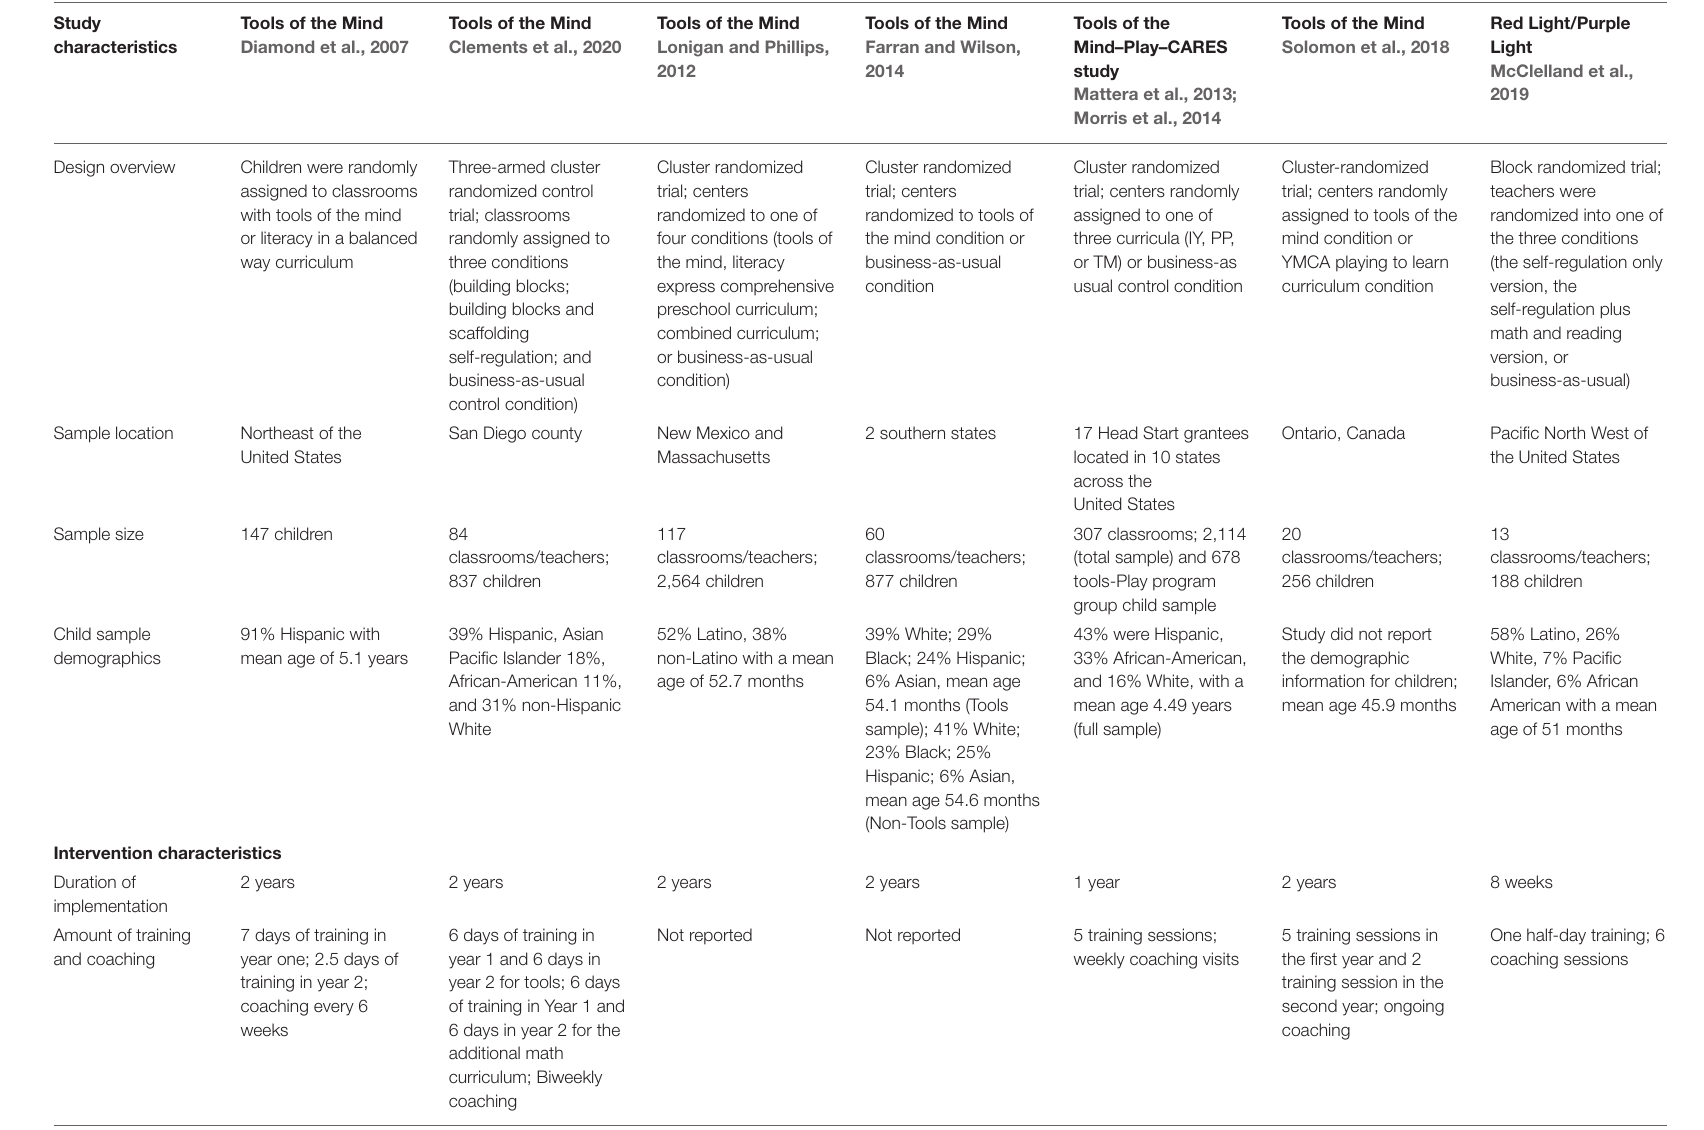
TABLE 3 | Background characteristics of the promoting play and direct training